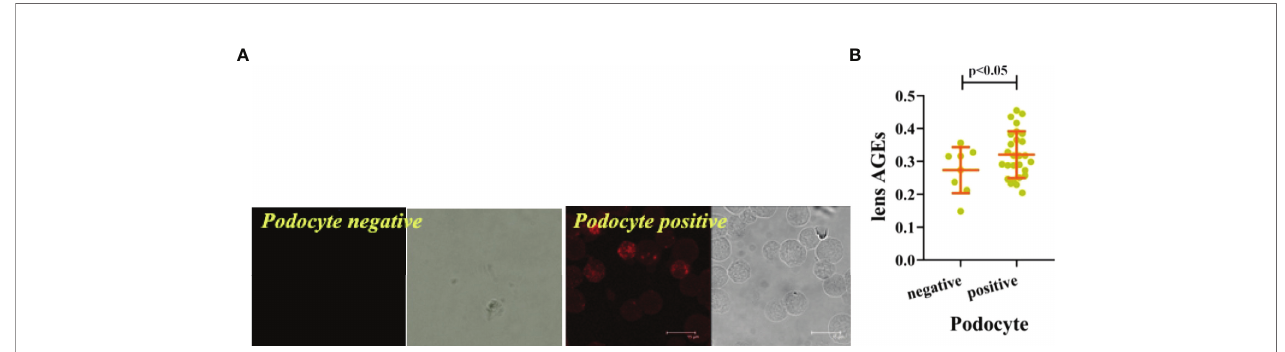
FIGURE 3 | The lens AGEs in the podocyte-positive group of DKD patients were higher than those in the podocyte-negative group. (A) The lens AGEs in the podocyte-positive group of DKD patients were higher than those in the podocyte-negative group (n = 27 in the podocyte-positive group; n = 8in the podocyte- negative group). (B) Comparison of lens AGEs between the podocyte-positive group and the podocyte-negative group (n = 27 in the podocyte-positive group; n = 8 in the podocyte-negative group).